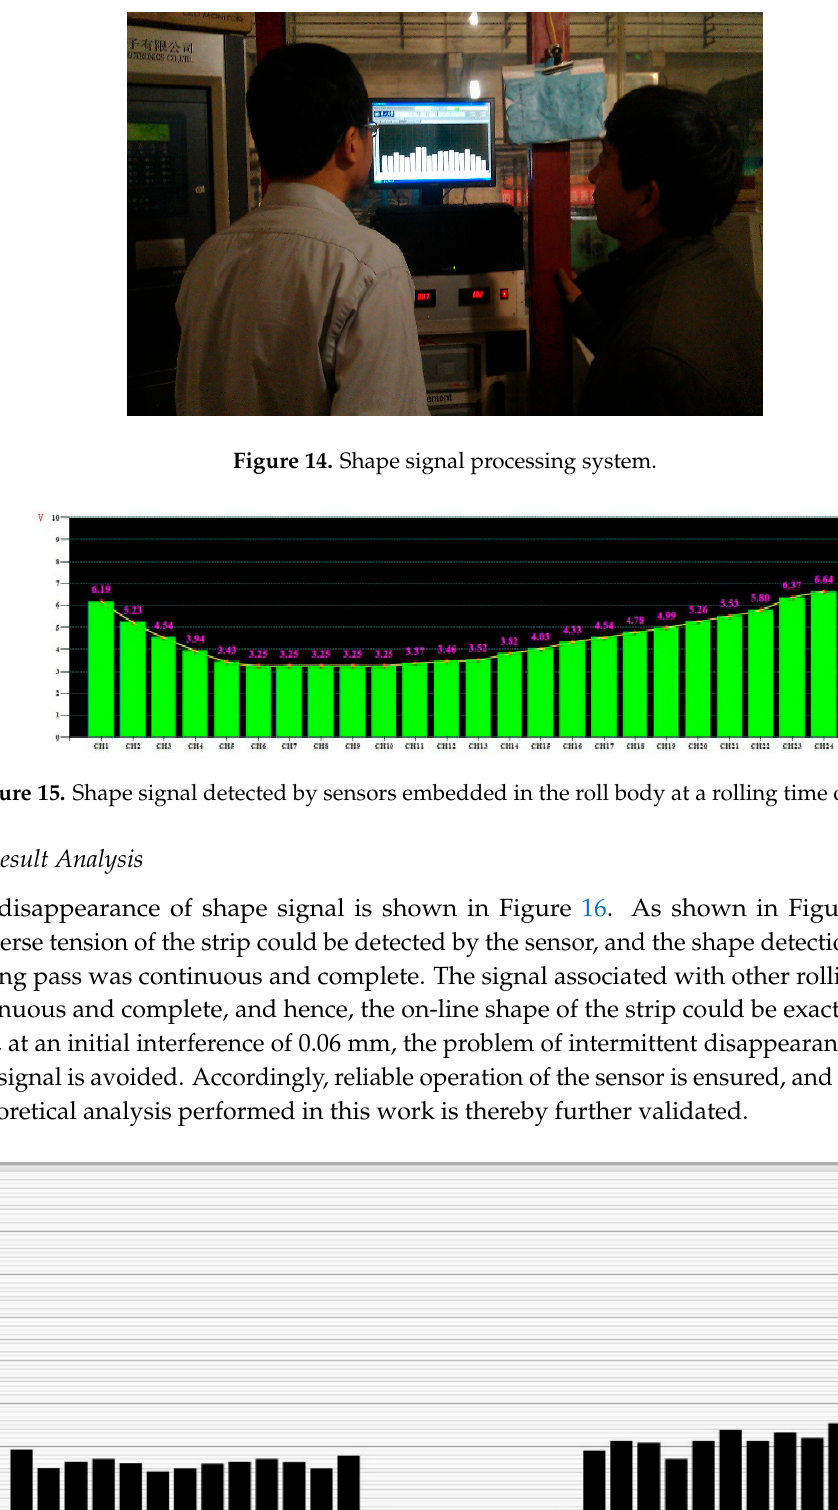
Figure 13. Test field.